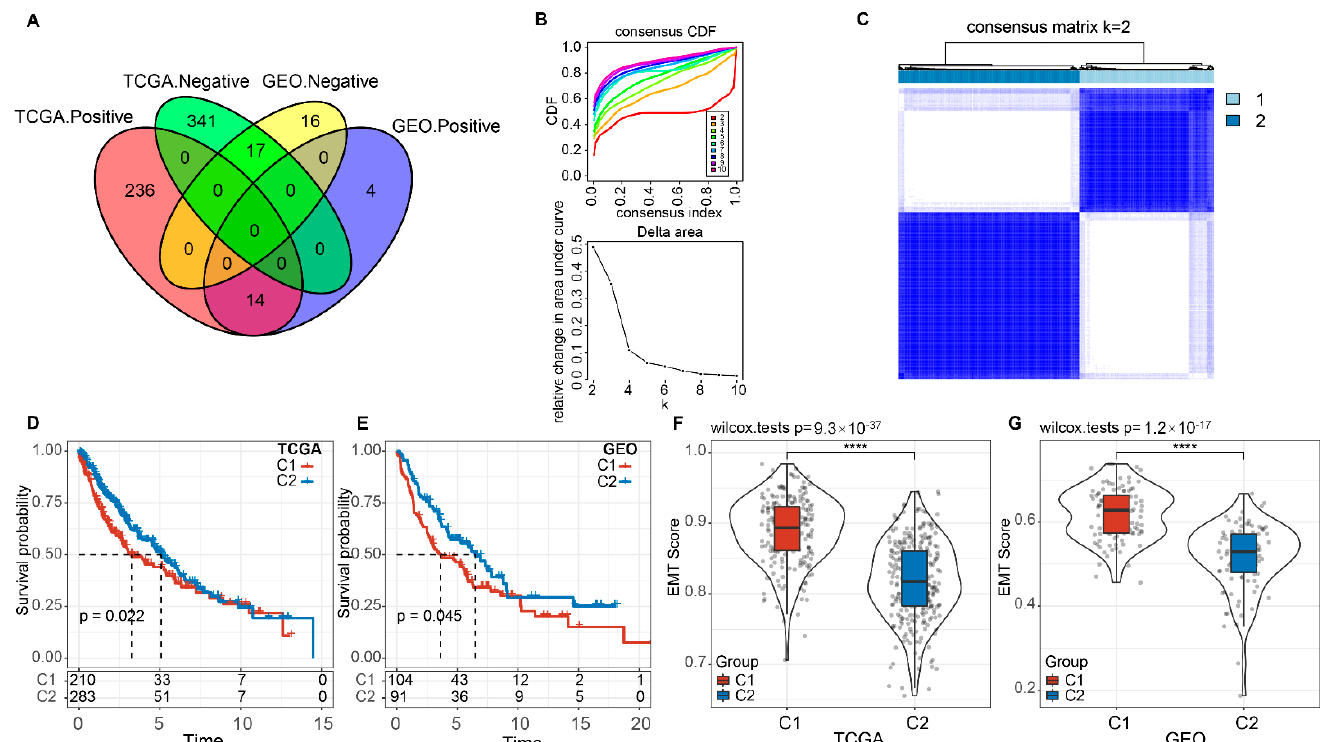
Figure 1. The EMT-associated lncRNAs subtypes in TCGA. ( A ) The intersection Venn diagram between EMT activity-related lncRNAs in the TCGA and GEO arrays. ( B ) The CDF curve and CDF Delta area curve in TCGA queue samples. ( C ) The clustering heat map of TCGA samples with Consensus K = 2. ( D ) The OS-time prognostic survival curve of EMT-associated lncRNAs subtypes in TCGA. ( E ) The OS-time prognostic survival curve of molecular subtypes in GEO. ( F ) The differences in EMT activity between the two molecular subtypes in the TCGA cohort. ( G ) The differences in EMT activity between the two molecular subtypes in the GEO cohort. Ns; p > 0.05; **** p < 0.0001.